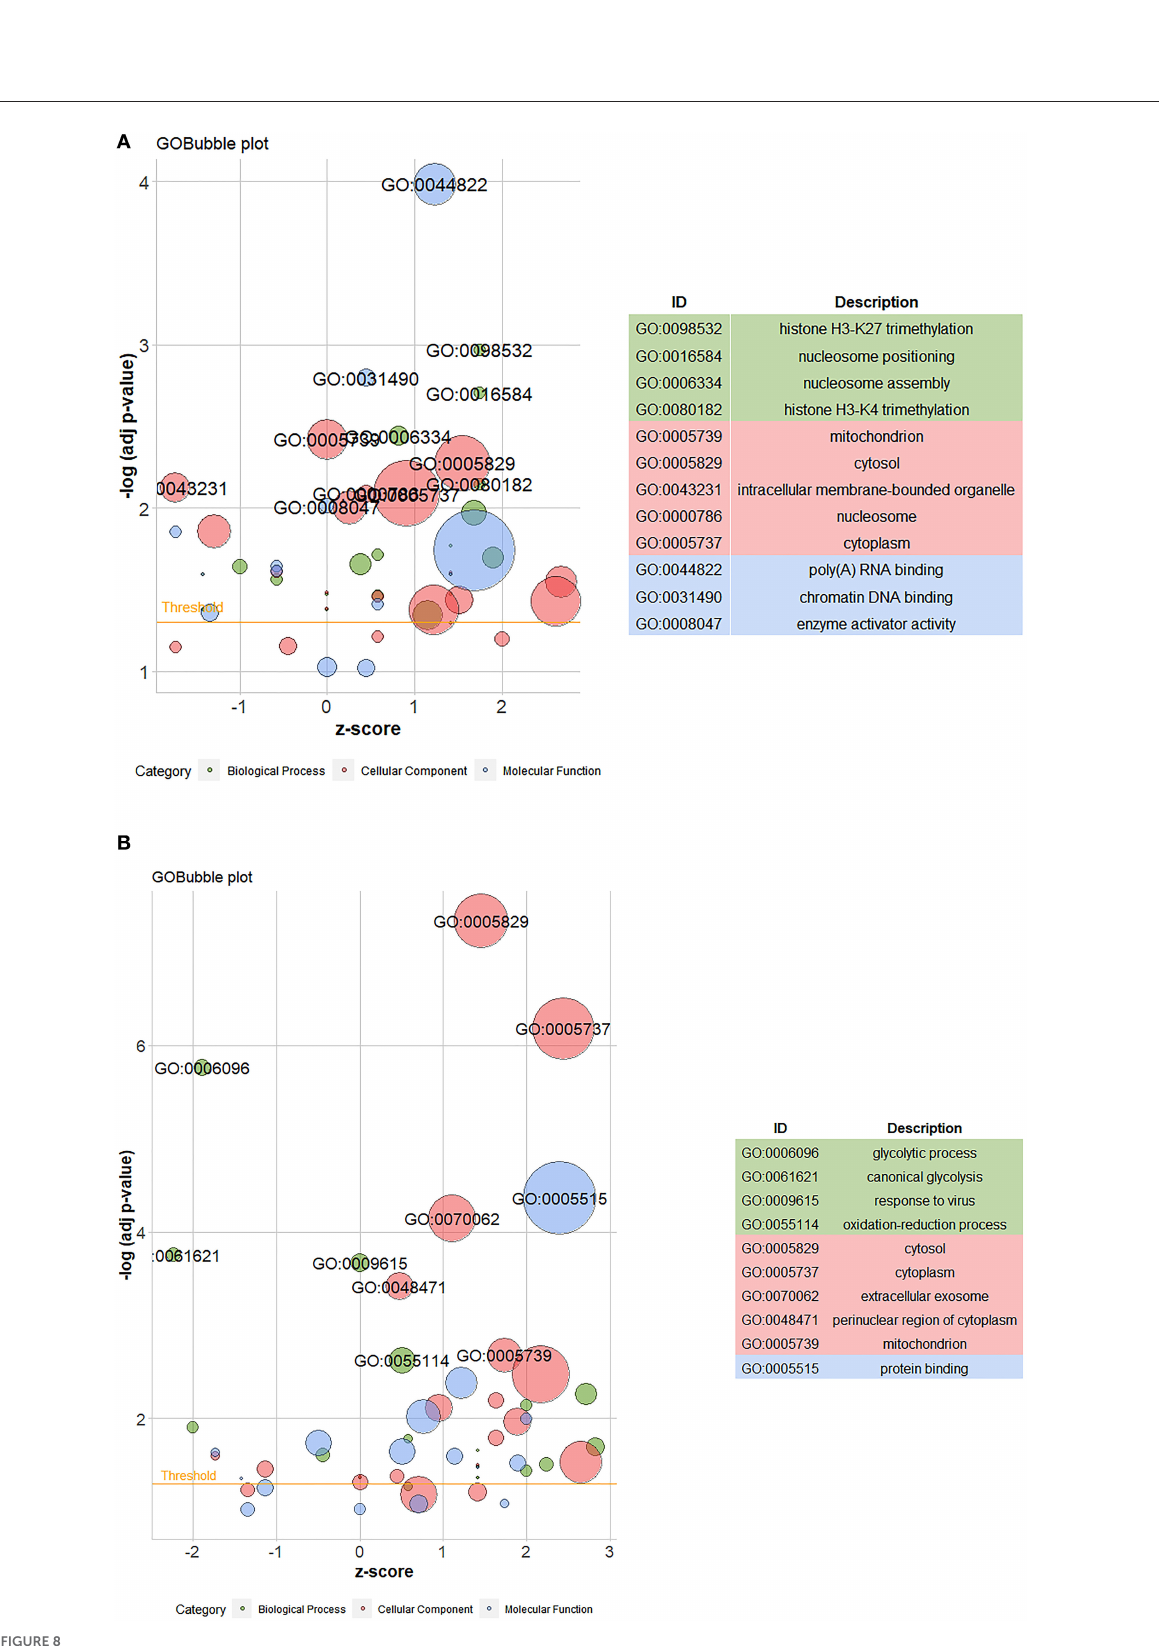
FIGURE8 (A) The GO bubble map of differential proteins between control (0 mg/mL phosphate residue) and fish sausage group (0.13 mg/L phosphate residue); (B) is the GO bubble map of differential proteins between positive control (1 mg/L phosphate residue) and control group (0 mg/L phosphate